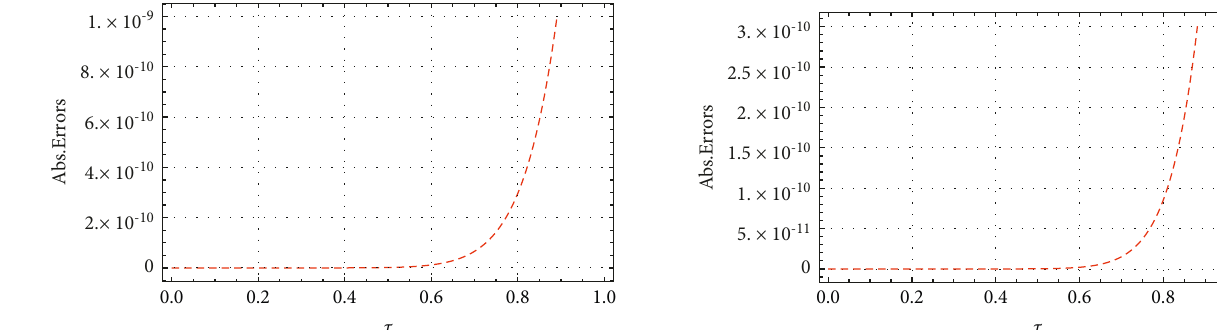
Figure 14: The absolute error for the imaginary part of Example 3.